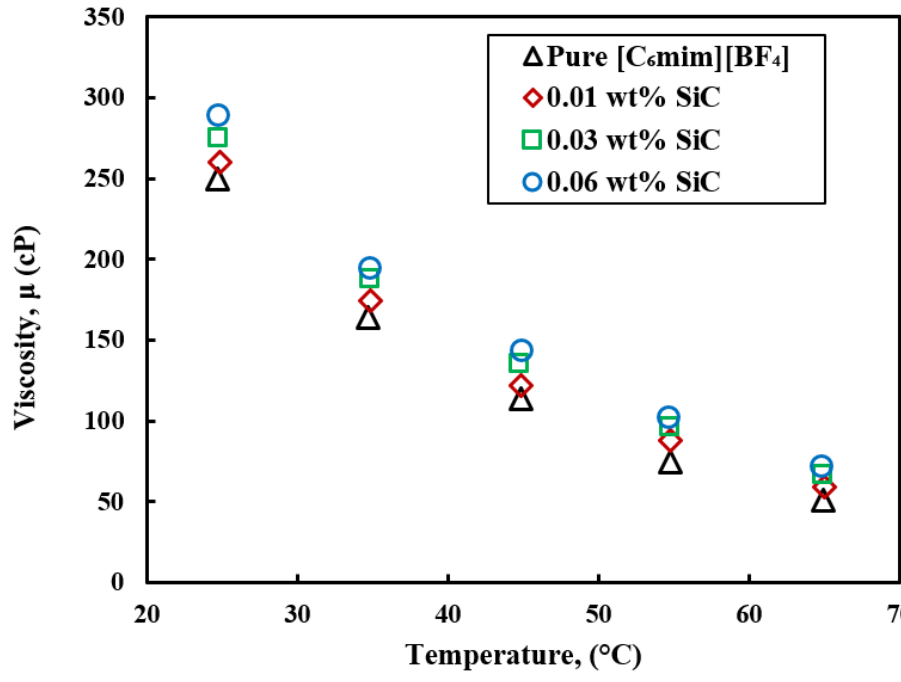
Figure 15. Viscosity of ILs-based nanofluids (SiC nanoparticles) as a function of temperature [54]. Reproduced with permission from [Chen], [. Sol. Energy Mater. Sol. Cells]; published by [Elsevier], 2017.